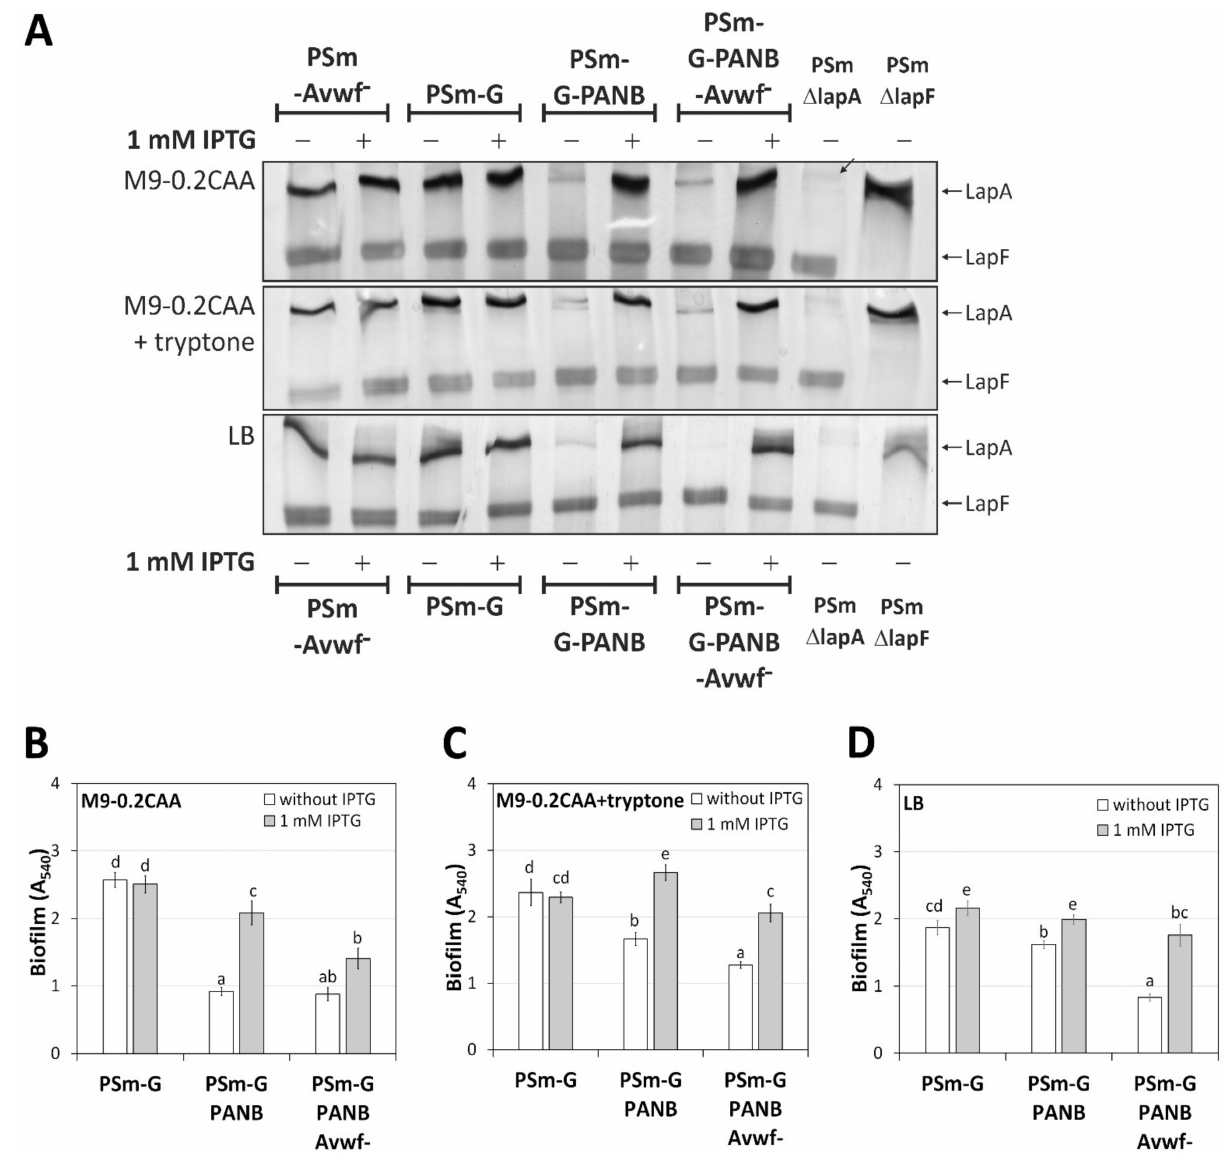
Figure 6. SDS-PAA gels and biofilm of P. putida PSm-G-based strains and biofilm. ( A ) SDS-PAA gel electrophoresis of crude cell lysates, 40 µ g of total protein is loaded to each lane. The media in which cells were grown for preparing crude cell lysates are shown on the left of the gel image. Cells were grown with and without 1 mM IPTG. The strains used in the analysis are shown above and below the figure. PSm ∆ lapA and PSm ∆ lapF strains were used as negative controls for LapA and LapF. Arrows indicate LapA and LapF on the right side of the figure. The inclined arrow indicates an unknown protein complex. ( B ) Biofilm of PSm-G-based strains in M9-0.2CAA, ( C ) M9-0.2CAA+tryptone and ( D ) LB in the presence and absence of 1 mM IPTG. An arithmetical average of at least three biological parallels with 95% confidence intervals are given. Homogeneity groups are shown above the columns by lower-case letters. Identical letters denote nonsignificant differences ( p ≥ 0.05) between averages of biofilm. Multifactorial ANOVA was used for statistical analysis, analysed separately by